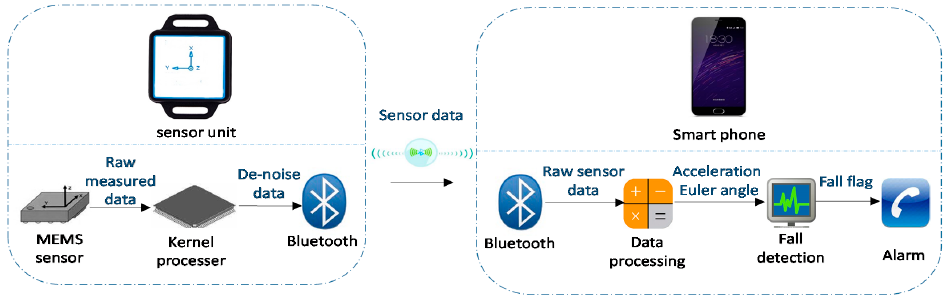
Figure 1. Highly portable, sensor-based fall monitoring system. MEMS: microelectrometrical system.